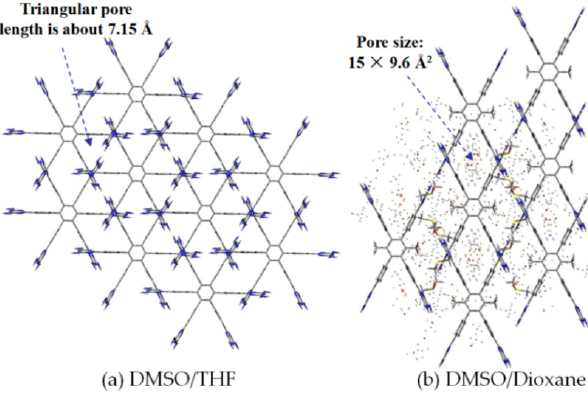
Figure 27. Structures of building motifs 30a (Figure 27 a ), 30b (Figure 27 b ).